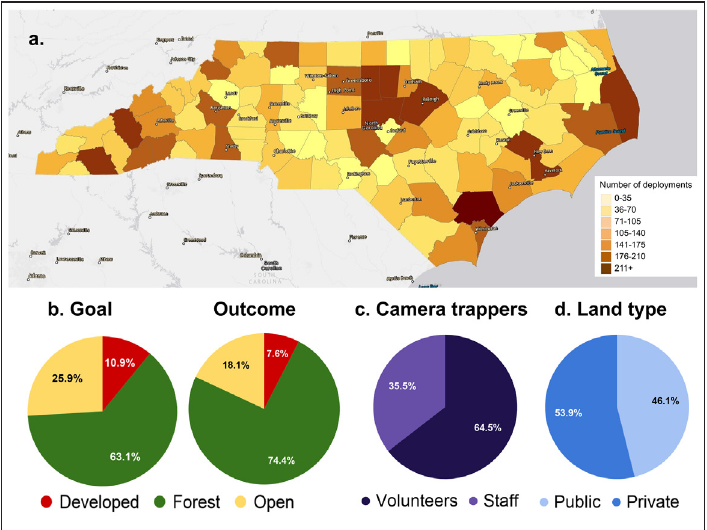
Figure 4 (a) The number of camera traps per North Carolina county. (b) The intended ( left-hand pie chart ) and resulting ( right-hand pie chart ) habitat distribution of camera traps. (c) The majority (64.5%) of camera traps were set by citizen scientists. (d) The distribution of sites across private (48.1%) and public (51.9%) lands was near even.